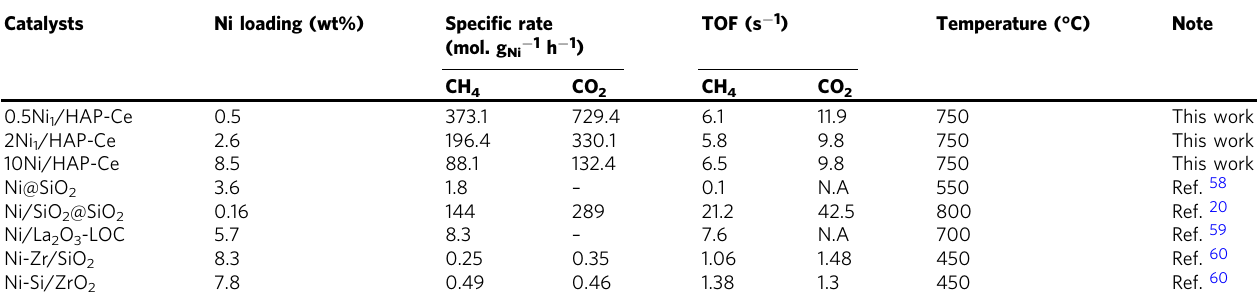
Table 1 Reaction rate of Ni/HAP and Ni/HAP-Ce catalysts